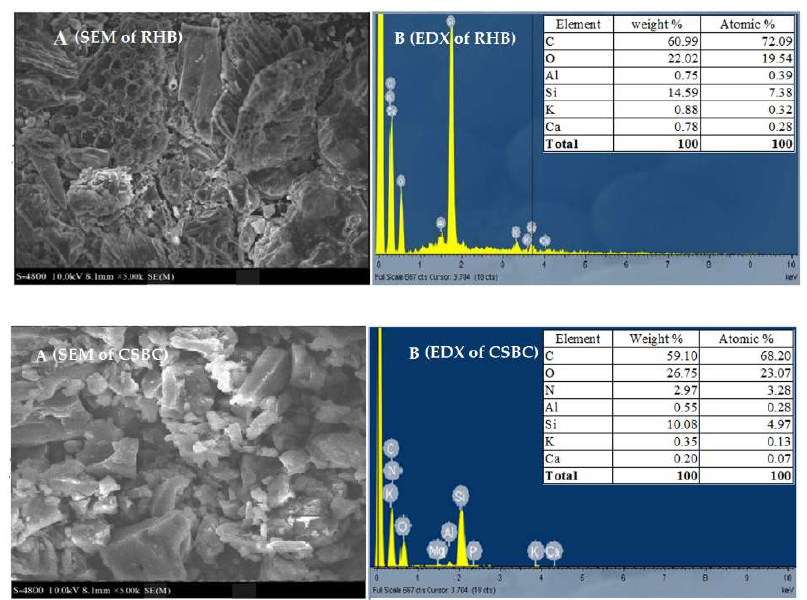
Figure 3. The FTIR analysis of RHB and CSBC.